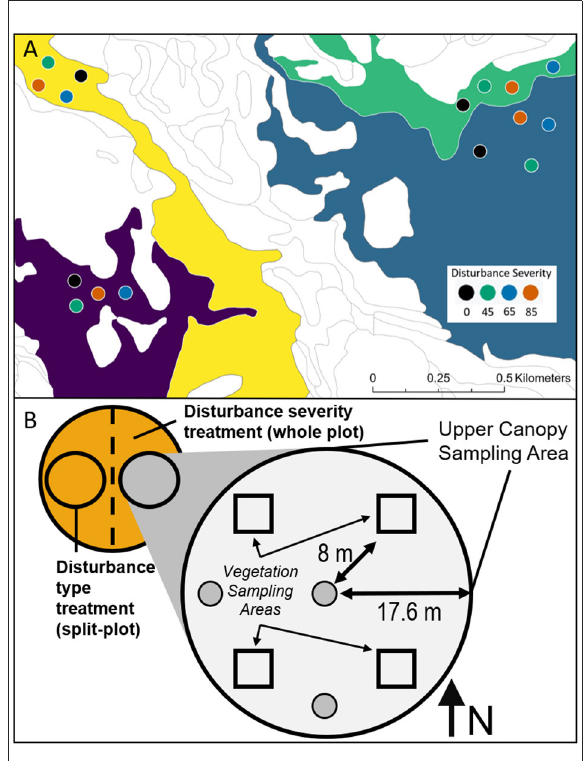
FIGURE1 Map of Forest Threshold Resilience Experiment (FoRTE) replicates (A) and split-plot design (B) . Replicates, which are used as experimental blocks, represent four different land ecosystem types and are designated by color with non-experimental land left white. Within each replicate, there are four randomly assigned disturbance severities representing 0, 45, 65, and 85% gross defoliation, which are designated by color (A) . Each plot is likewise bisected into two subplots, with each half randomly assigned either top-down or bottom-up disturbance type (B) . The subplot is used as the experimental unit throughout the experiment.